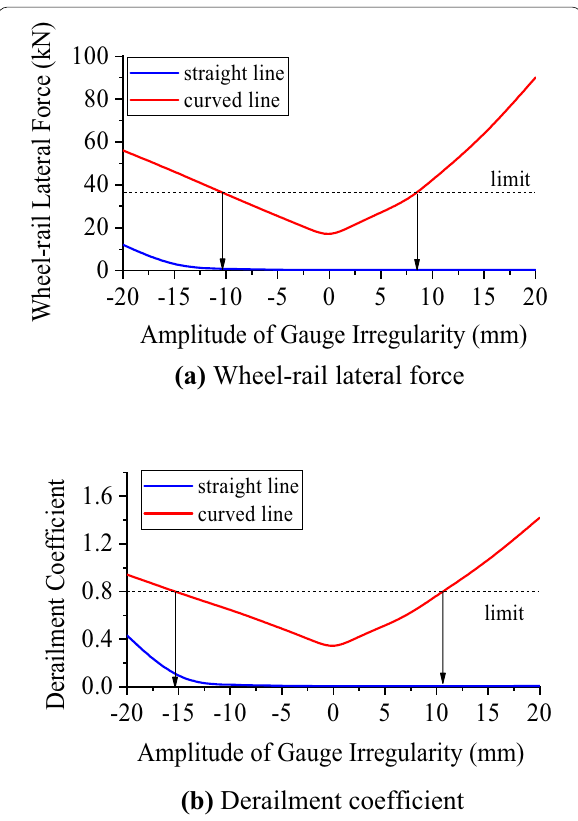
Figure 10 Influence of variation in gauge irregularity amplitude on wheel-rail lateral force and derailment coefficient under straight